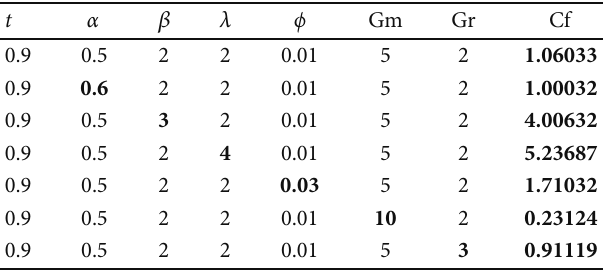
Table 2: The e ff ect of di ff erent parameters on Cf .